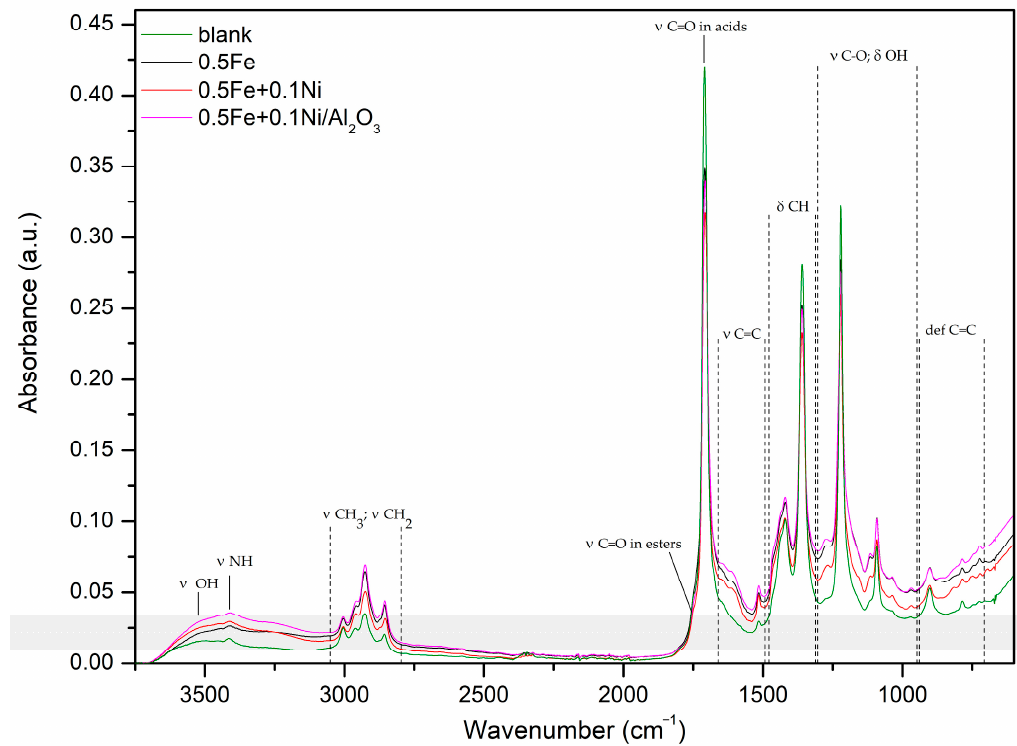
Figure 7. Infrared spectra of BM bio-crudes at 330 °C and for a residence time of 10 min.